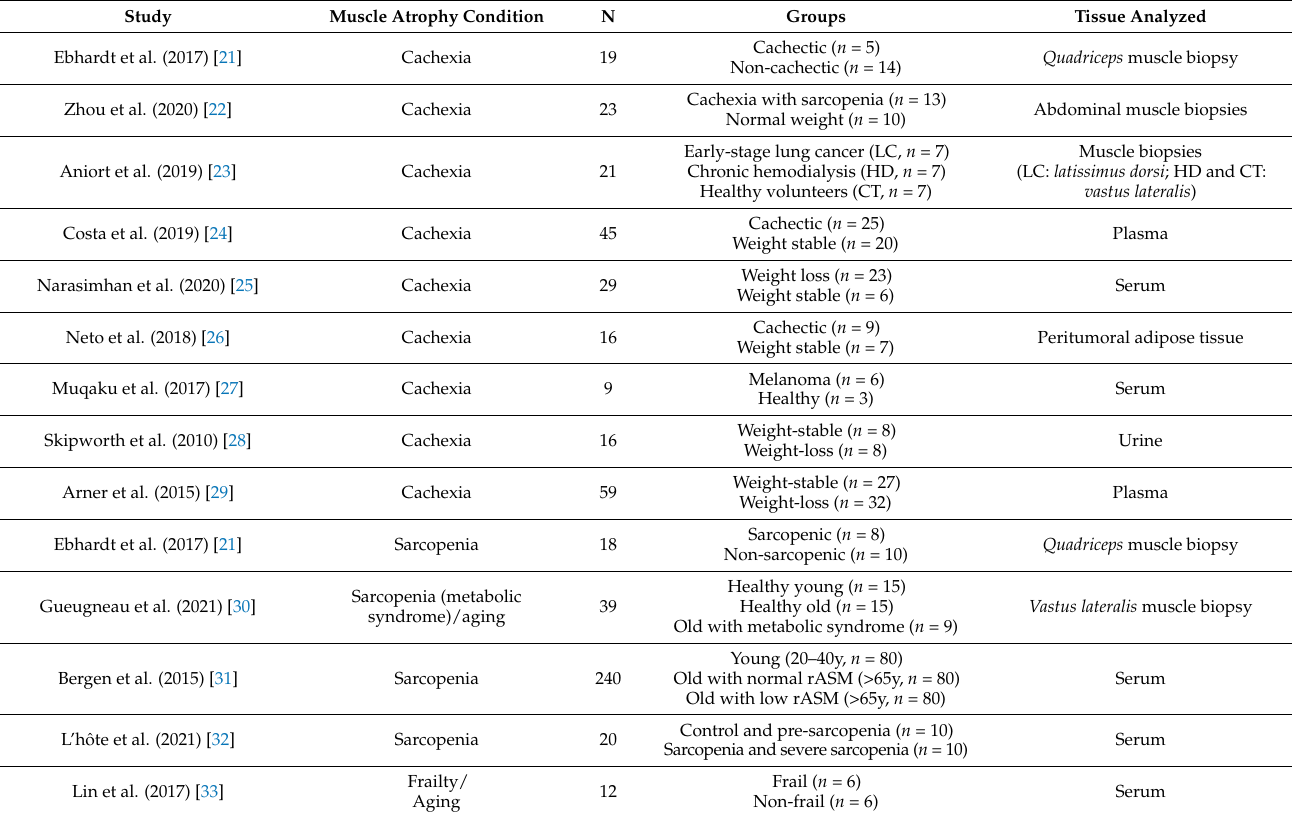
Table 1. Study details of articles